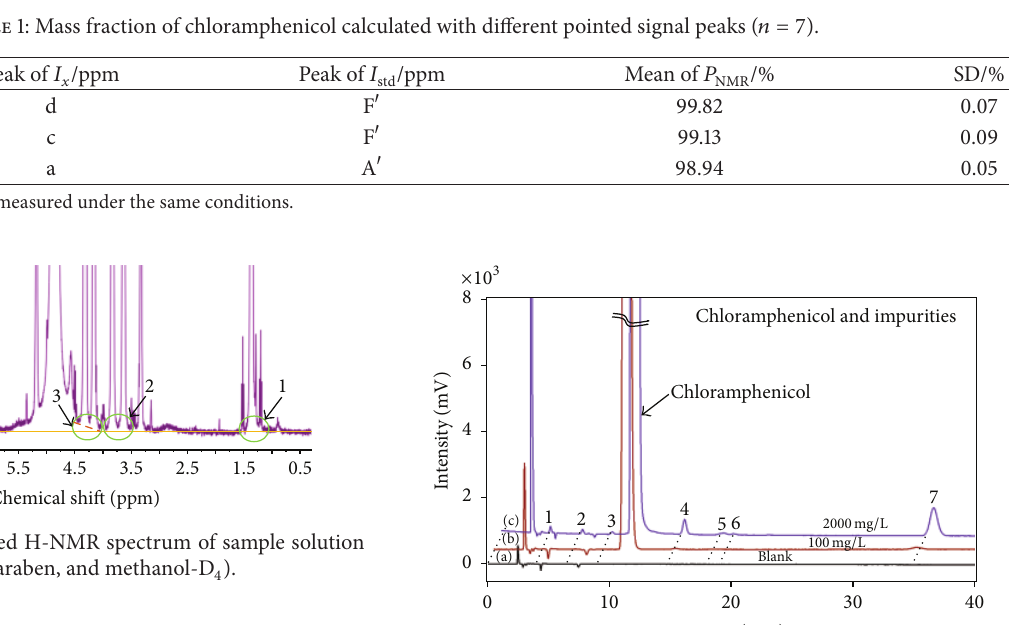
Table 1: Mass fraction of chloramphenicol calculated with different pointed signal peaks ( 𝑛 = 7 ).